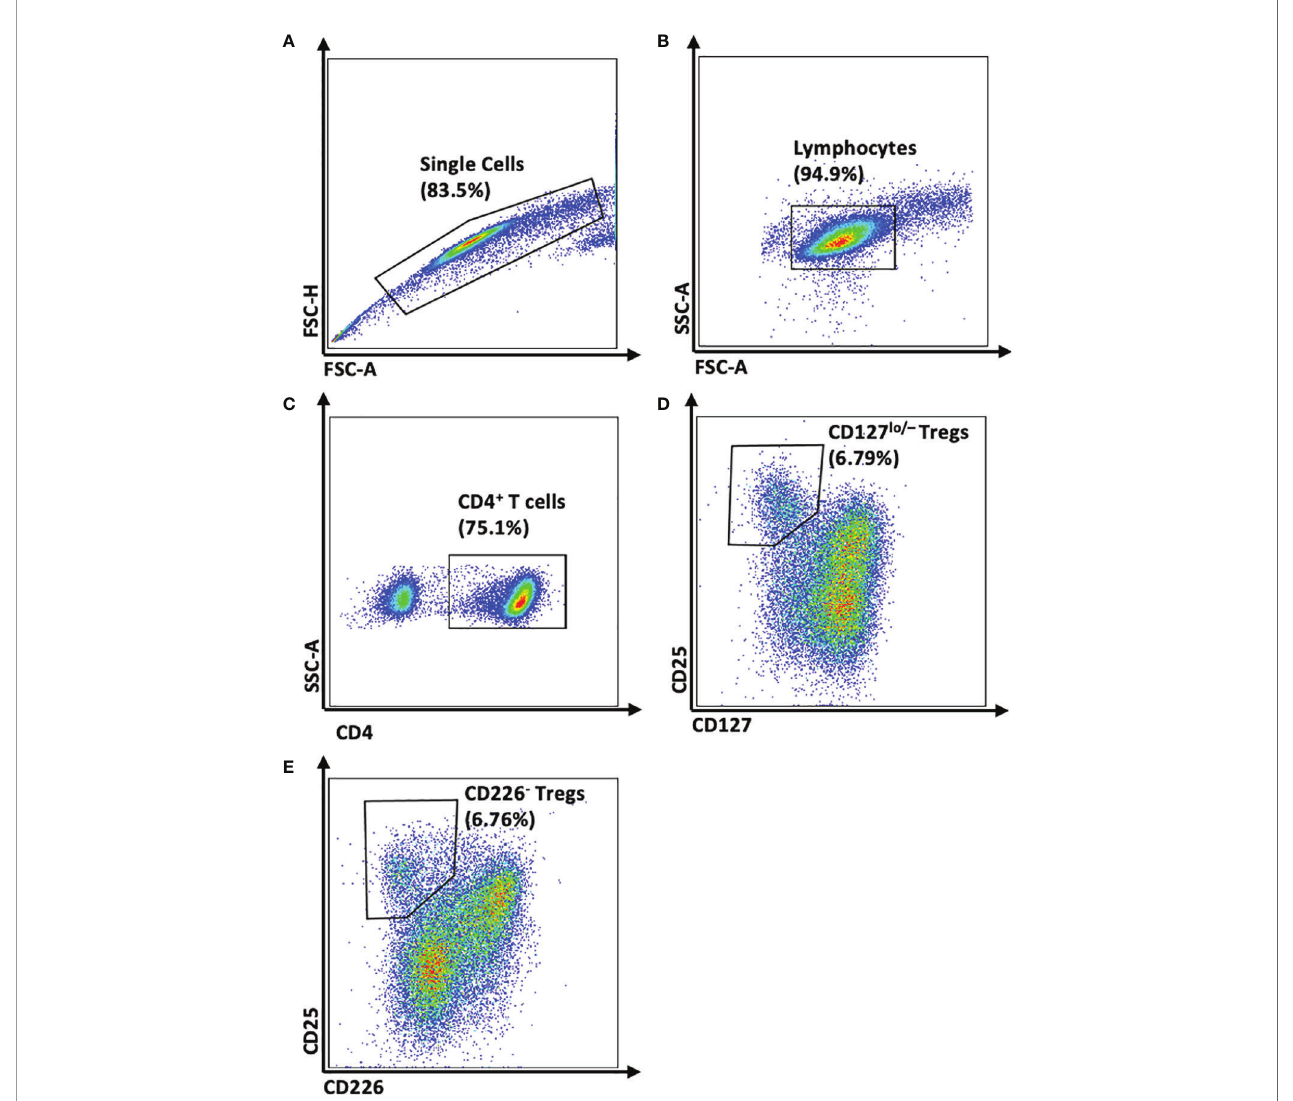
FIGURE 1 | Gating Strategy for FACS Isolation of Paired CD4 + CD25 + CD127 lo/- and CD4 + CD25 + CD226 - Tregs. Representative fl ow plots demonstrate the method by which CD127 lo/- or CD226 - Tregs were isolated from CD4 + T-cell enriched PBMC using a BD FACSAriaIII Cell Sorter. (A) Singlet gating was performed using forward scatter area (FSC-A) versus forward scatter height (FSC-H). (B) Lymphocytes were gated on FSC-A and side scatter area (SSC-A). (C) From the CD4 + T cell fraction, (D) CD25 + CD127 lo/- Tregs and (E) CD25 + CD226 - Tregs were